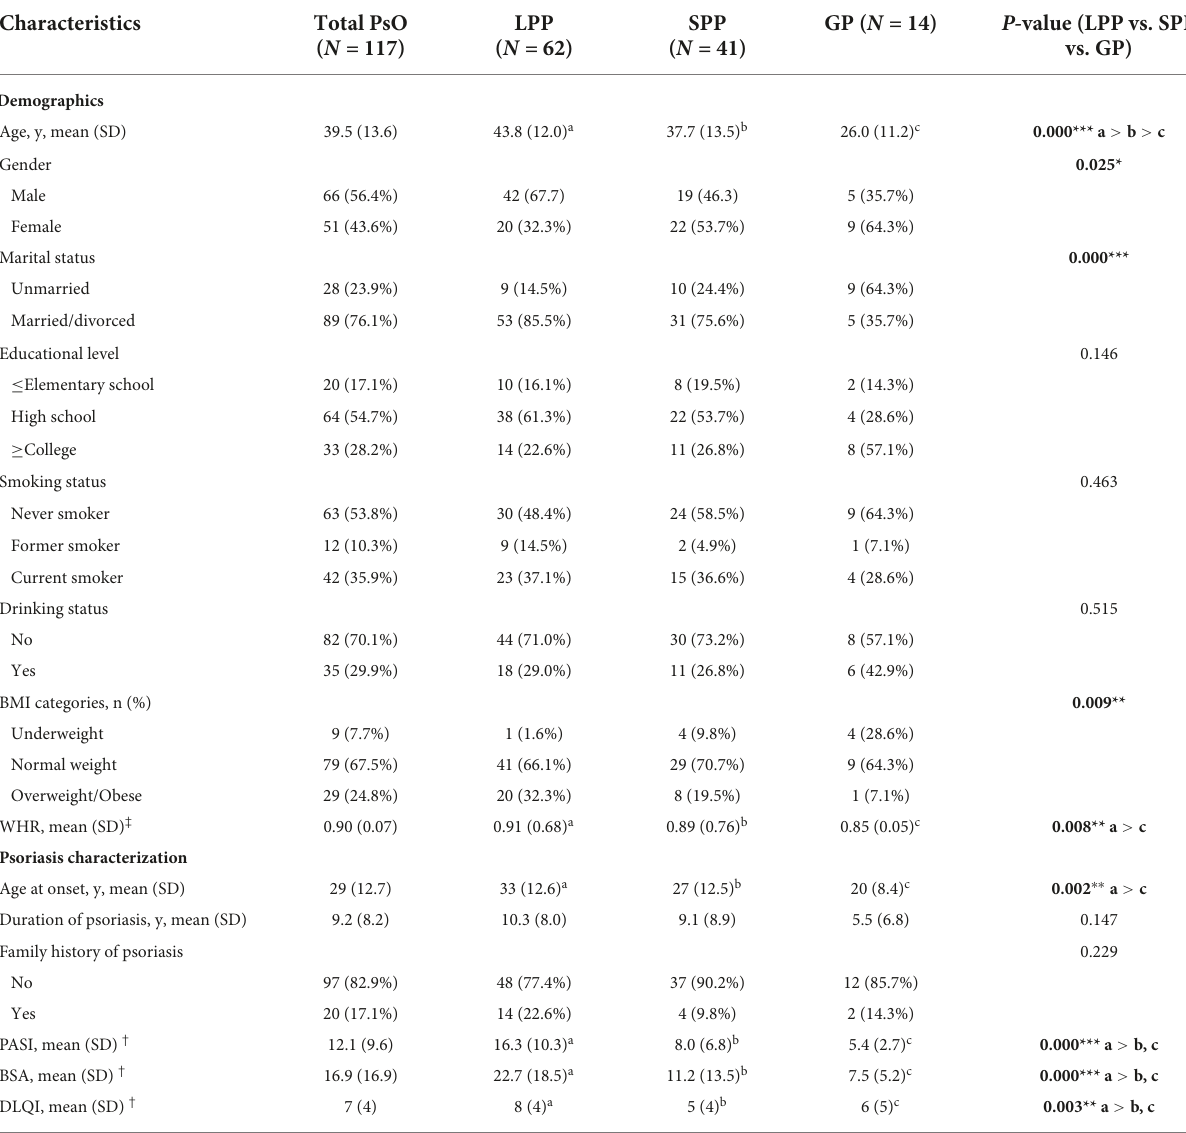
TABLE 1 Demographics and clinical characteristics of the participating subjects.